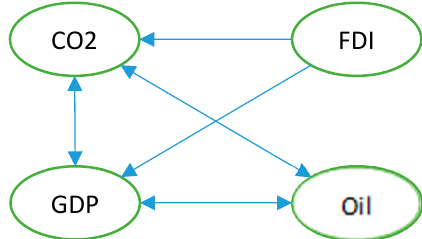
Figure A2. Summary of long ‐ run Granger causality test.